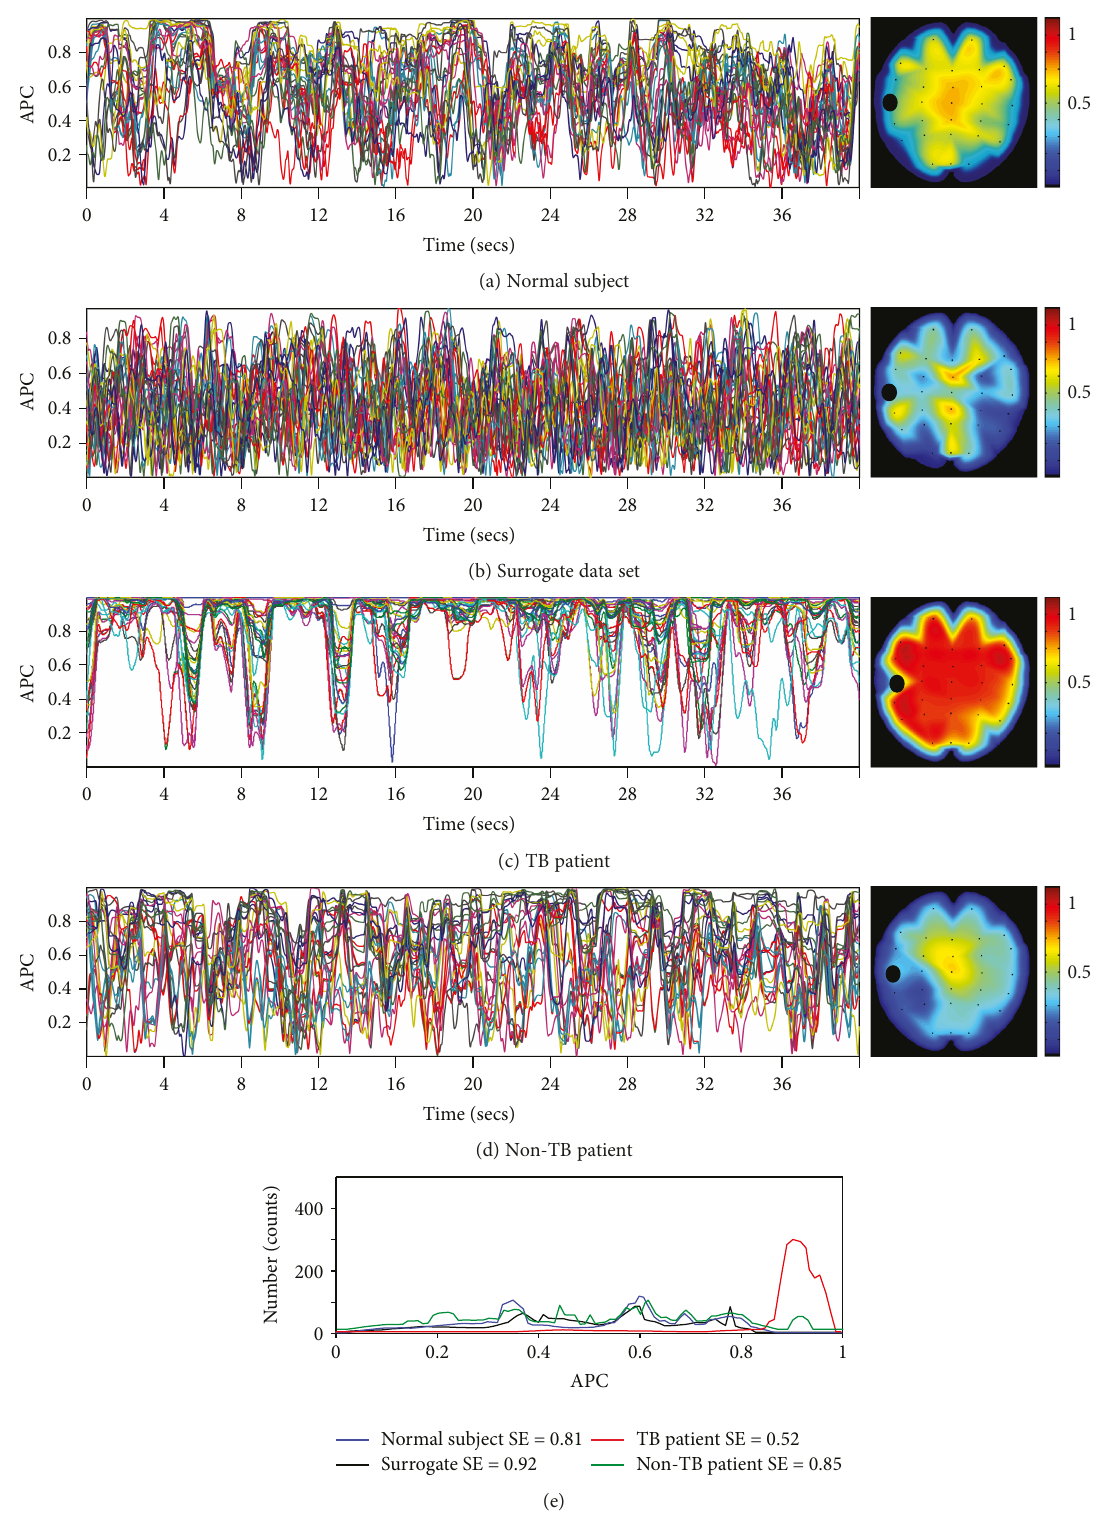
Figure 1: Representative resting-state APC values corresponding to a normal subject (a), a surrogate data set (b), a non-TB patient (c), and to a TB patient under persistent AVHs that led to TBs (d), respectively. Each line of plots represents the coupling between the left temporal region and the remaining brain sites during a representative 40 sec window. The spatial distribution of the coupling mode is shown for each case with an attached map to the right. The distributions of the APC values, measured for each case, are shown in (e). Synchrony- derived entropy values estimated for each of the four distributions are given under the graph,